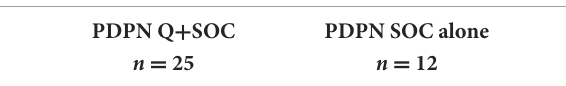
TABLE 2 Pain characteristics of patients with diabetic neuropathy. Group PDPN Q + SOC PDPN SOC alone n = 25 n = 12 Time elapsed since onsetof pain associated with PDPN, mean; years (range;